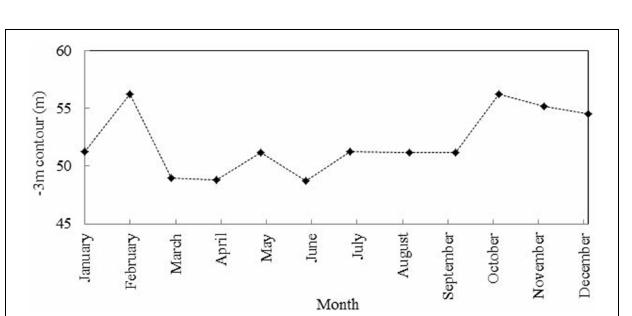
FIGURE 5 | Variability of monthly averaged position of the − 3m contour at J-O Coast.